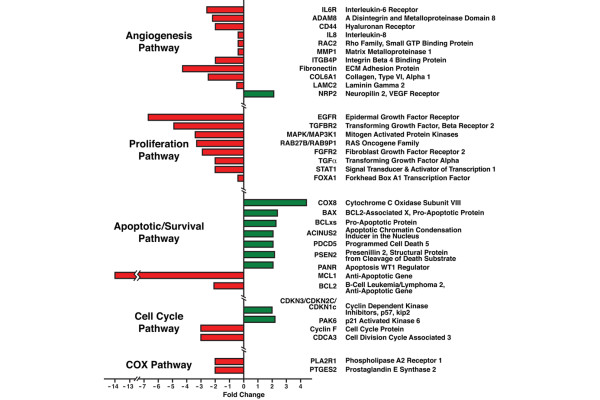
Treatment with celecoxib regulates gene expression in MDA-MB-231 cells. Differential gene expression was assessed by comparing MDA-MB-231 cells treated with or without 40 mmol/l celecoxib for 24 hours using the Affymetrix Human Genome 133A Gene Chip. Replicate microarray analyses were employed. A total of 44,760 genes were initially evaluated, and of these 1069 had a twofold or greater change. Selected results compare genes of interest associated with important cell pathways. Bars on the right represent an increase in gene expression and bars on the left indicate a decrease. COX, cyclo-oxygenase.